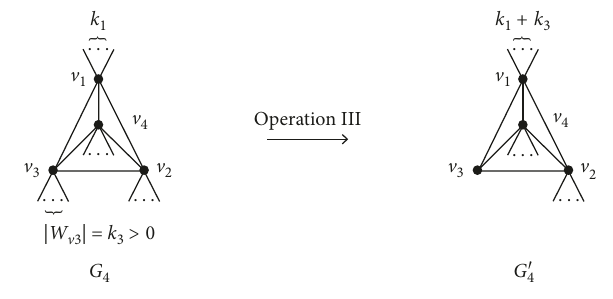
Figure 11: Operation III on graph G